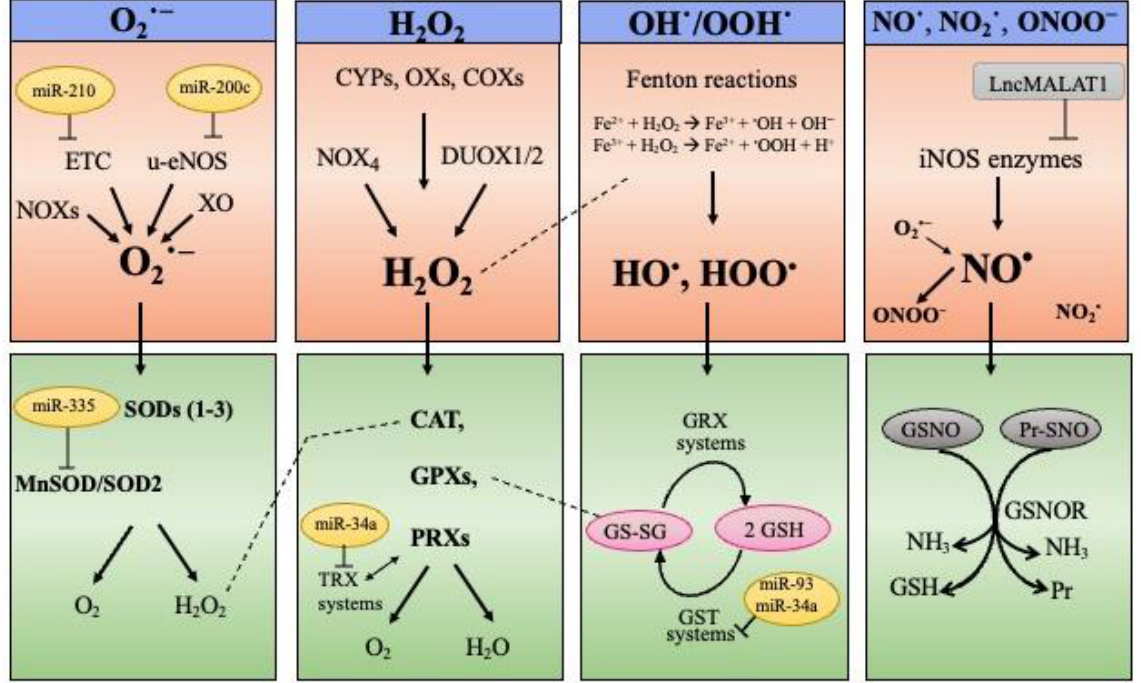
Figure 2. ROS and RNS biological sources and major scavenging pathways. ROS comprise the